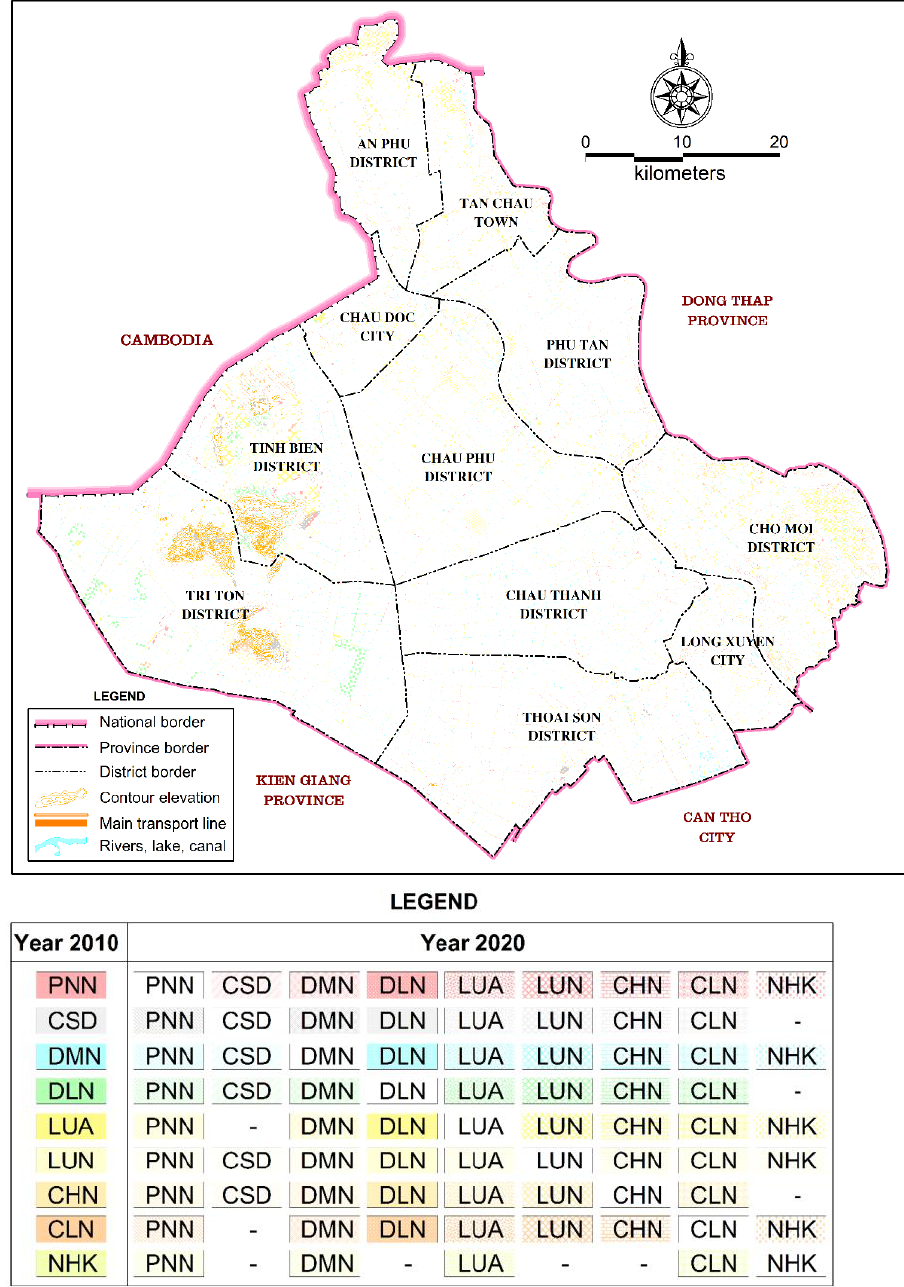
Figure 10. Map of land use changes for the period 2010—2020 in An Giang province.